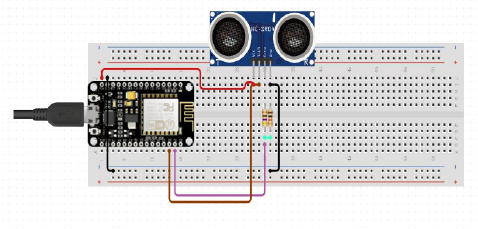
Figure 5. Planning of Ultrasonic Sensors